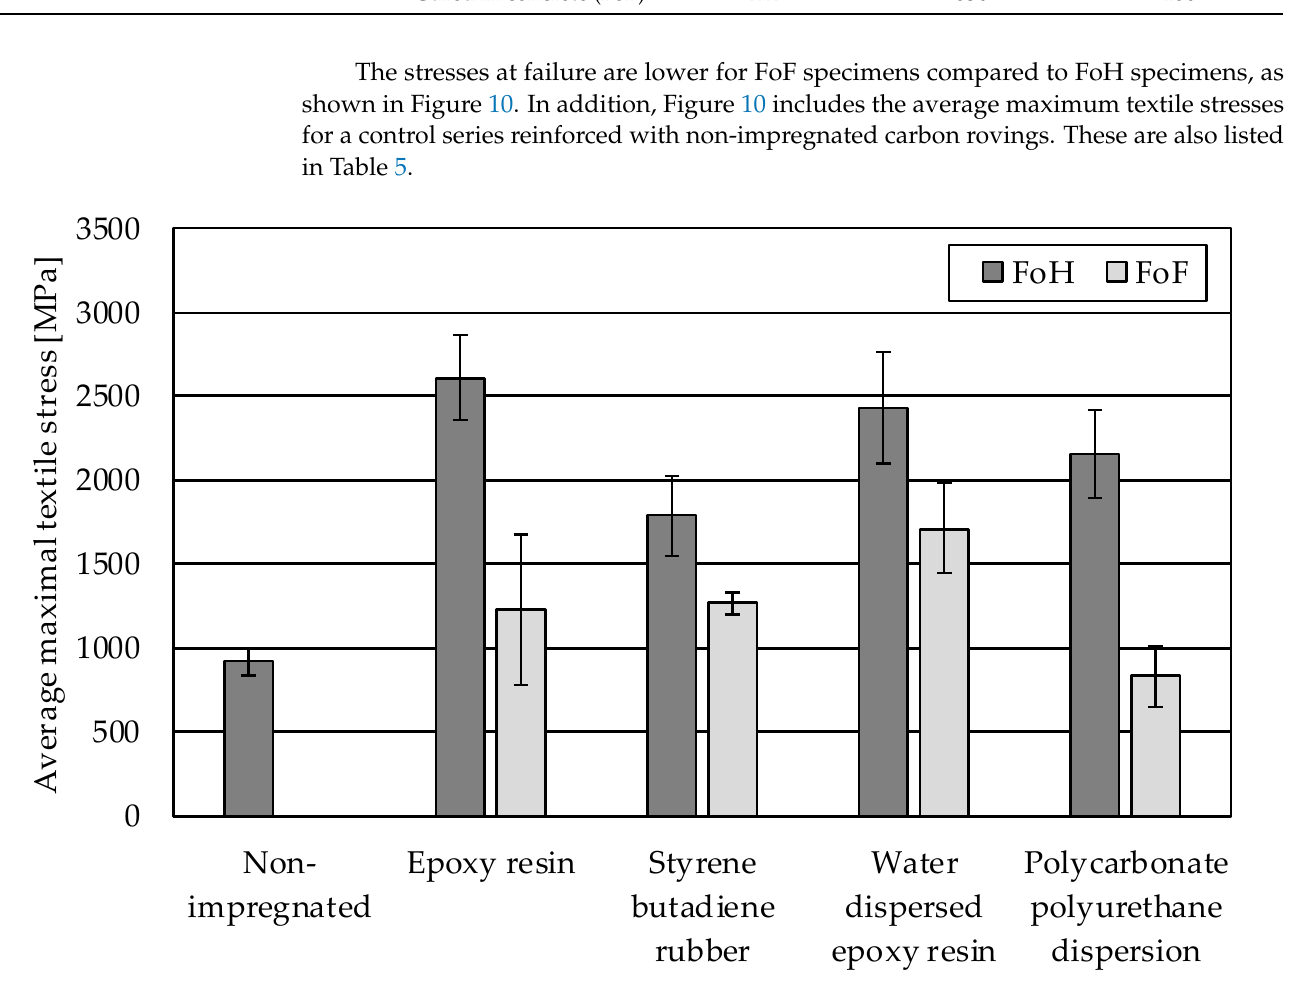
Figure 10. Comparison of the average maximum tensile stresses at breaking point for TRC tensile test specimens reinforced with different impregnated rovings and the uncoated control (error bars indicate standard deviation). Table 5. Maximum tensile stresses at breaking point for TRC tensile test specimens reinforced with impregnated rovings and the uncoated control.